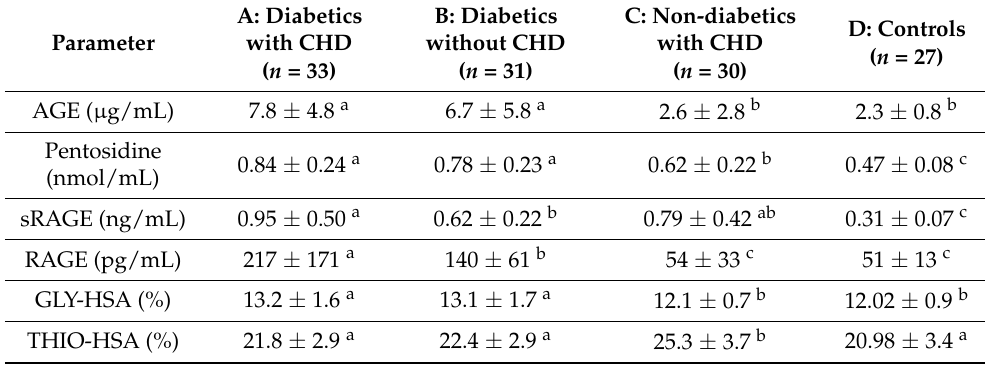
Table 1. Glycation and oxidation parameters evaluated in the four groups of subjects.